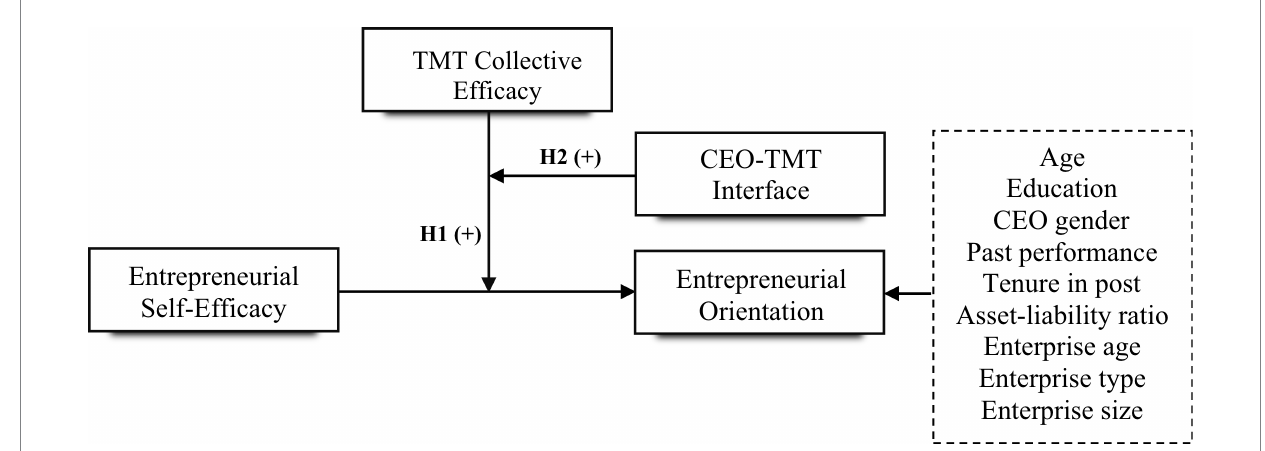
FIGURE 1 The hypothesized